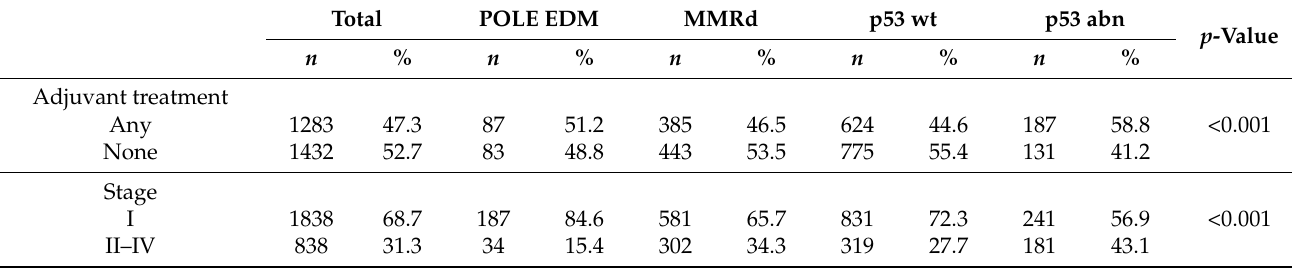
Table 4. Analysis of the International Federation of Gynecology and Obstetrics (FIGO) stage and adjuvant treatment distribution in terms of the patients’ molecular subtype out of the published trials